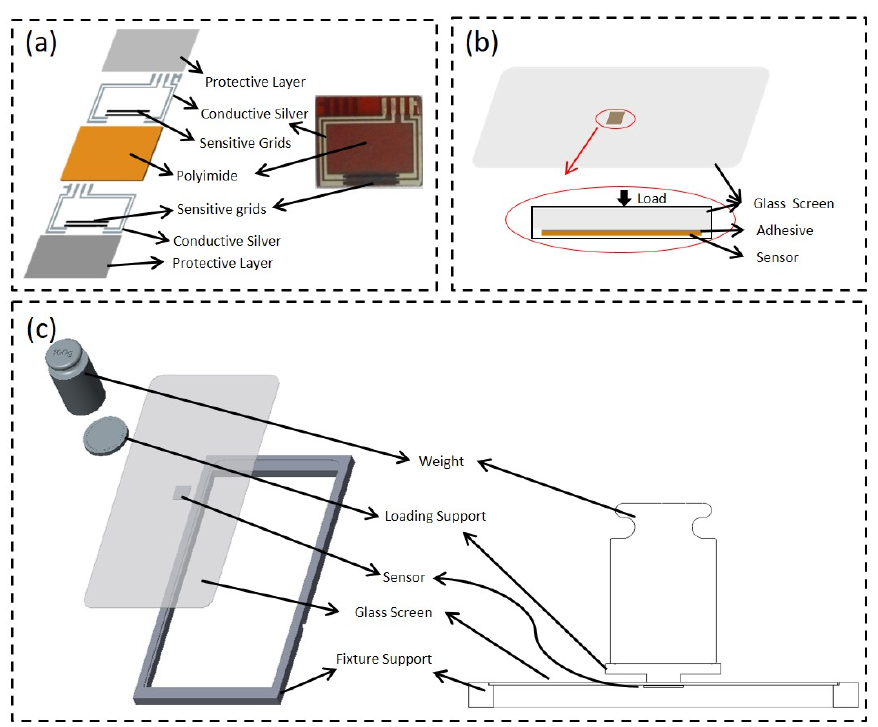
Figure 2. ( a ) Structure of the sensor; ( b ) schematic diagram of the arrangement of the adhesive and sensor on the glass screen; ( c ) schematic diagram of the loading status.